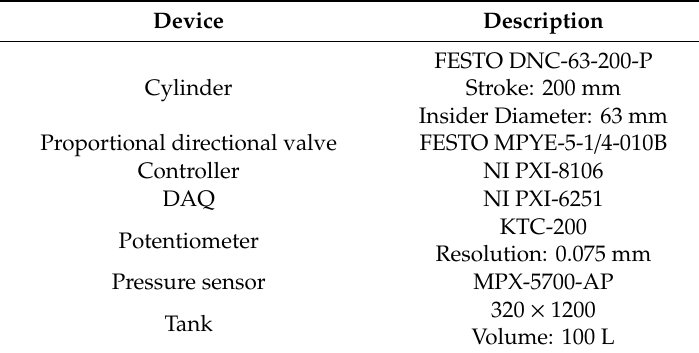
Figure 3. Experimental apparatus of the pneumatic system. Table 1. Experimental Specifications.